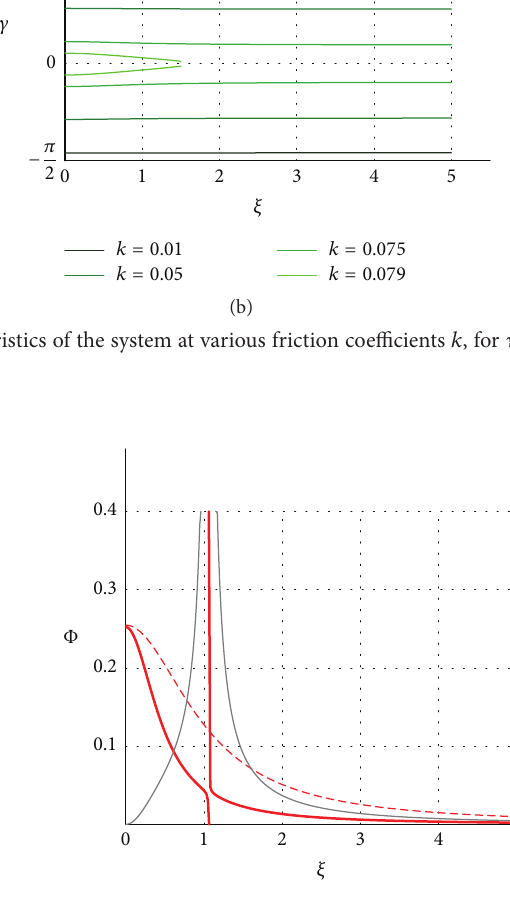
Figure 8: Amplitude of free oscillation of the block (bold red line), of the pendulum (thin grey line), and of the block without the pendulum (dashed line) for ] = 0.2 , 𝜇 = 0.01 , and 𝜆 = 0.1